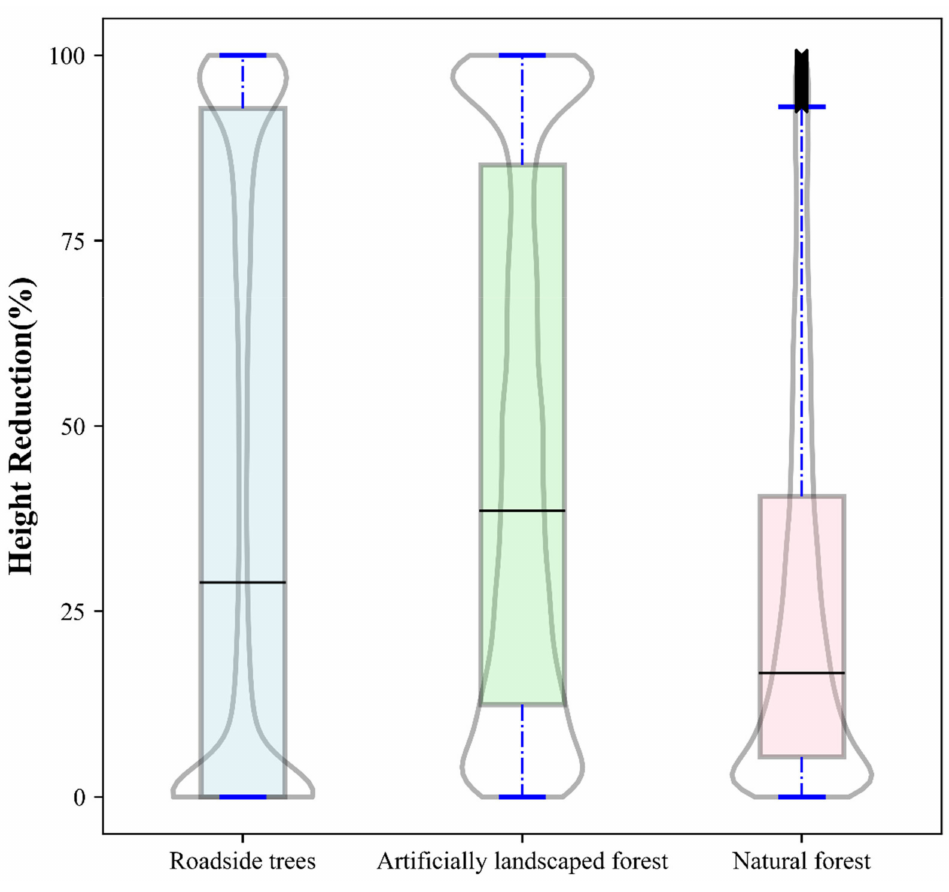
Figure 8. Height reduction